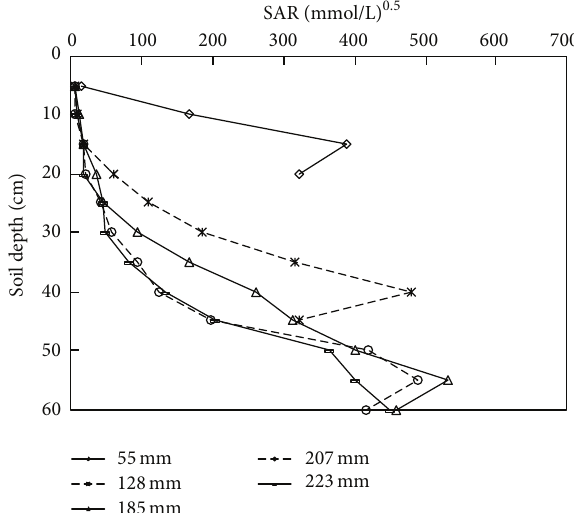
Figure 5: The depth distributions of SAR at 0 hour, just after irrigation has finished, under different water amounts